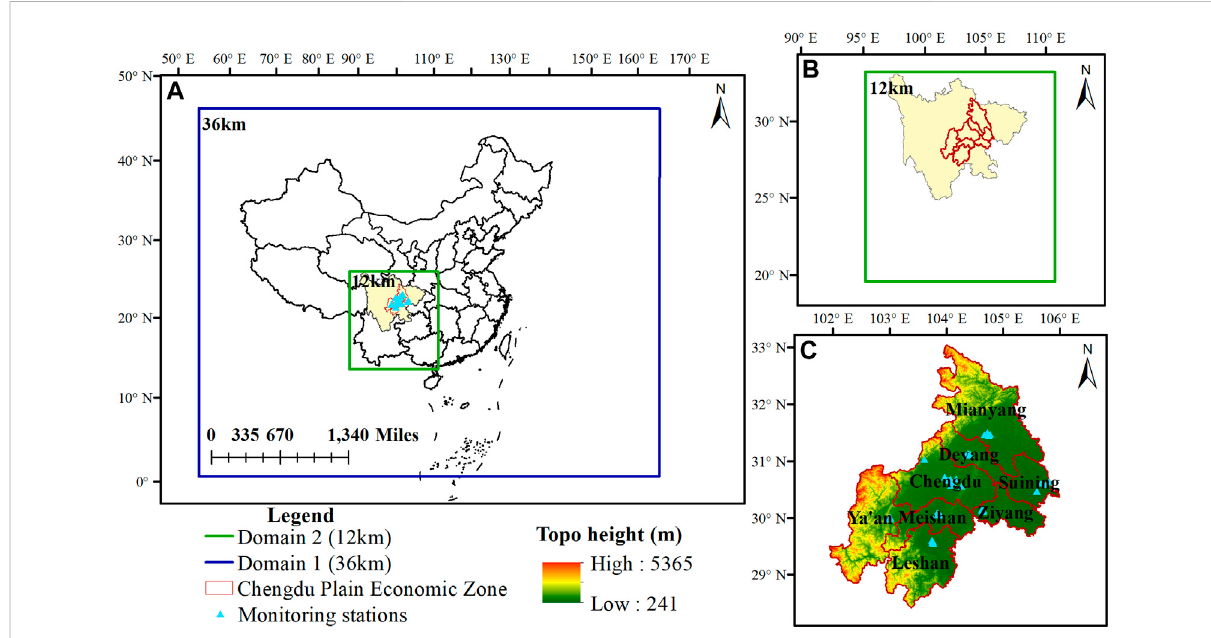
FIGURE 1 Modeling domains for (A) East Asia, (B) Sichuan and its surrounding area and (C) the CMA region. The blue triangles in (C) represent national air quality monitoring stations.